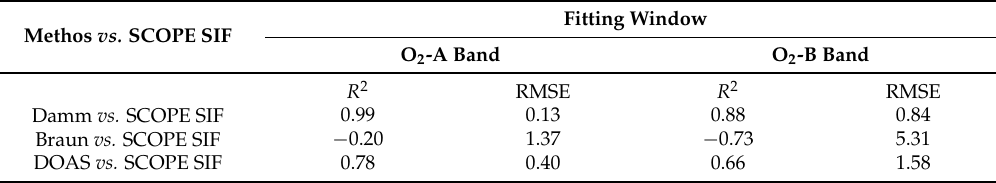
Table 6. Comparison of Damm method, Braun and DOAS methods.